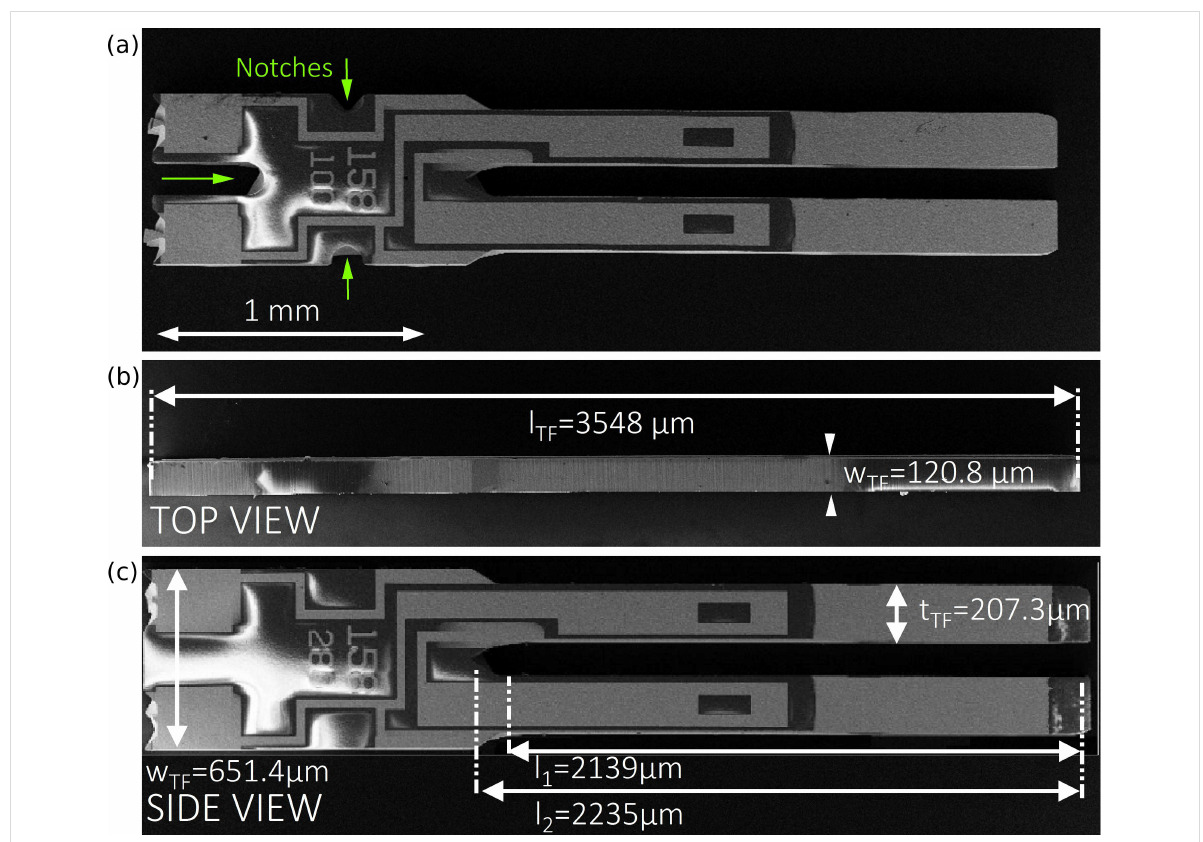
Figure 1: Determination of the geometric dimensions of a quarts tuning fork (Micro Crystal, type DS 26 used for “qPlus”-force sensors from SEM images. (a) Sideview of tuning fork made from quartz with notches (cf. arrows) at the basis. (b) Topview of the tuning fork for measureing its width by the wafer thickness. (c) Sideview of an alternative geometric layout of DS26-type tuning fork without notches at the basis.